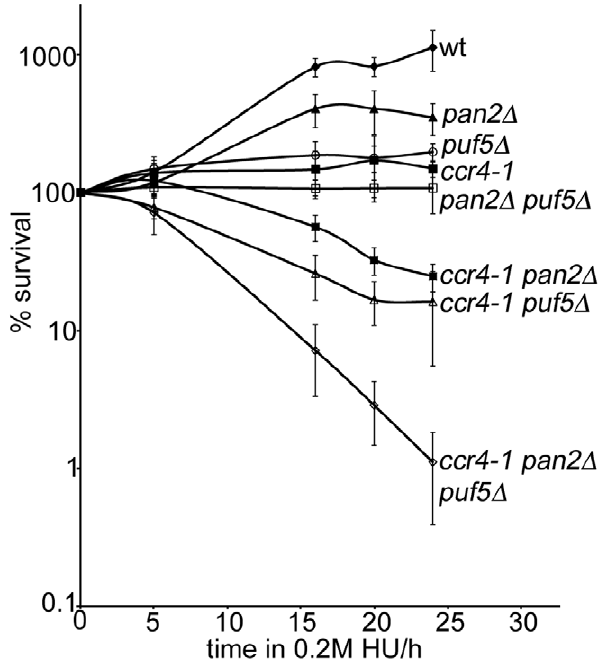
Figure 2. Puf5 has roles in response to HU that are independent of deadenylation. Survival in 0.2 M HU of the indicated strains was assayed over a 24 h time course. Shown are averages of six independent colonies and the standard deviation.